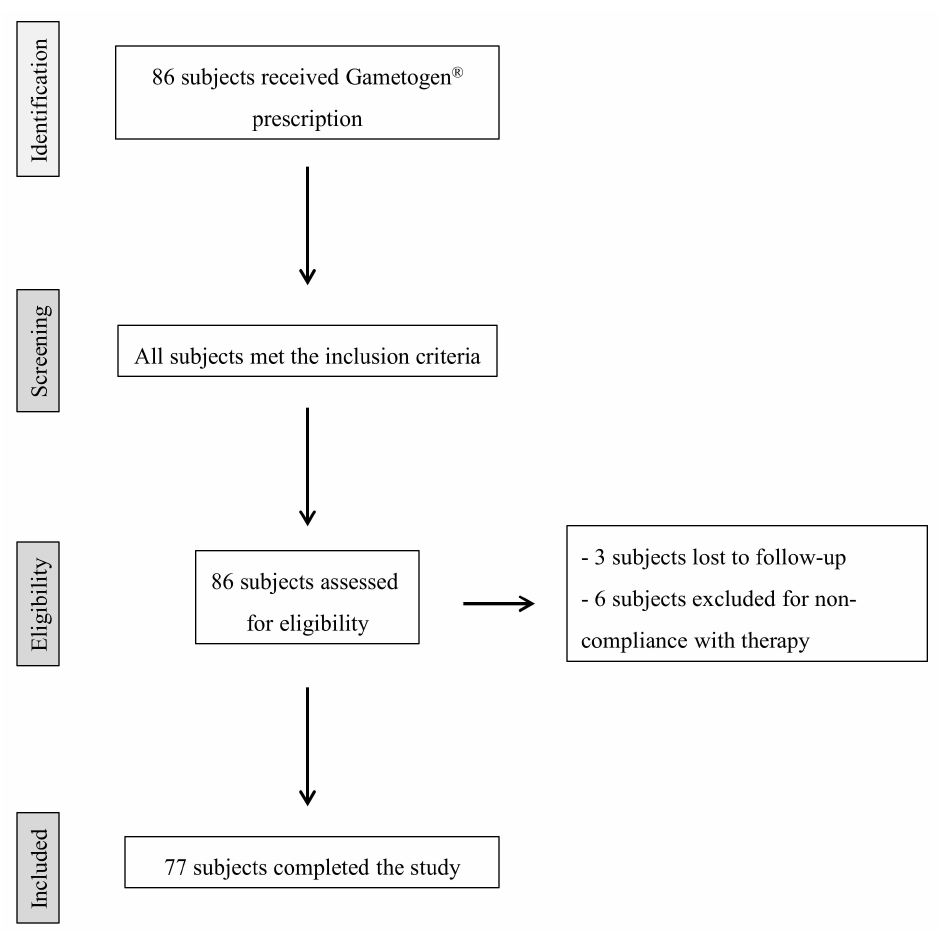
Figure 1. Flowchart of patient